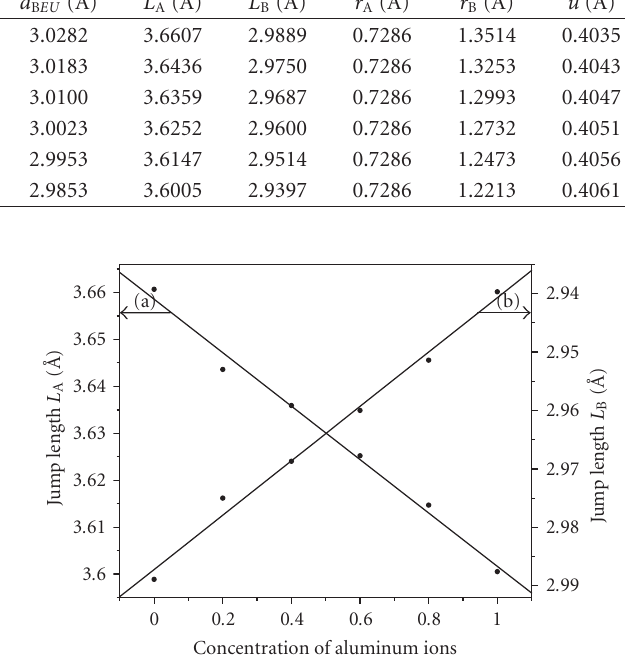
Table 3: X-ray parameters (error bar ± 0.002 ˚A): tetrahedral and octahedral bond lengths ( d A L and d B L ) and jump lengths ( L A and L B ), tetrahedral edge d A E , and shared and unshared octahedral edges ( d BE and d B EU ). Composition ( x )